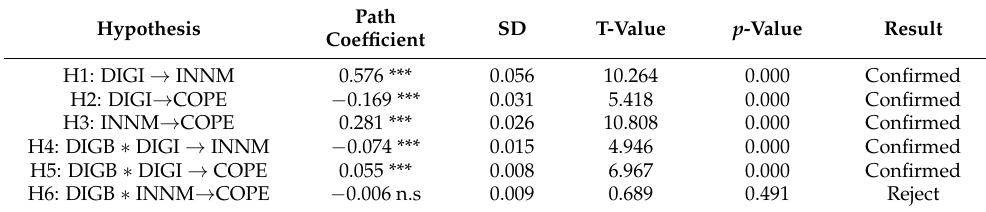
Table 7. Model Hypothesis (test moderation